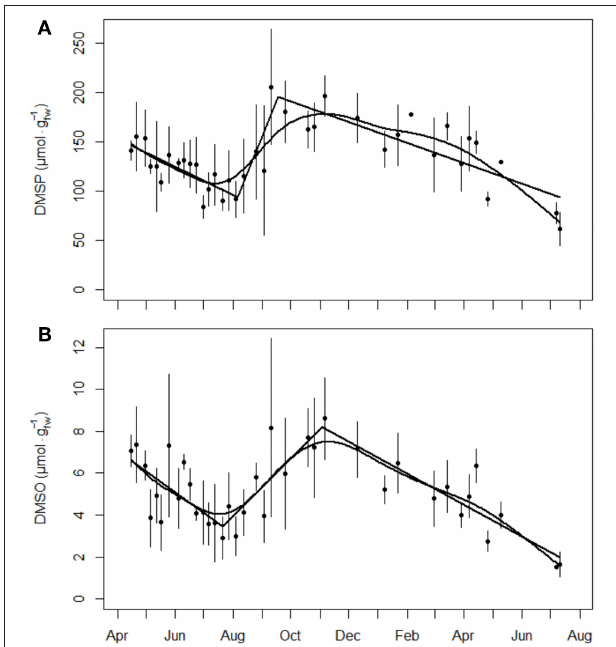
FIGURE 3 | Evolution of (A) the DMSP concentration ( µ mol.g − 1 fw ) and (B) the DMSO concentration ( µ mol.g − 1 fw ) in P. oceanica third leaf at 10m depth (mean ± sd, n = 3 except February 5, 2016 for DMSP and DMSO and July 7, 2016 for DMSO, n = 2). The solid black lines are predictions from segmented linear regression and cross-validated smoothing cubic spline analyses on leaf concentrations.